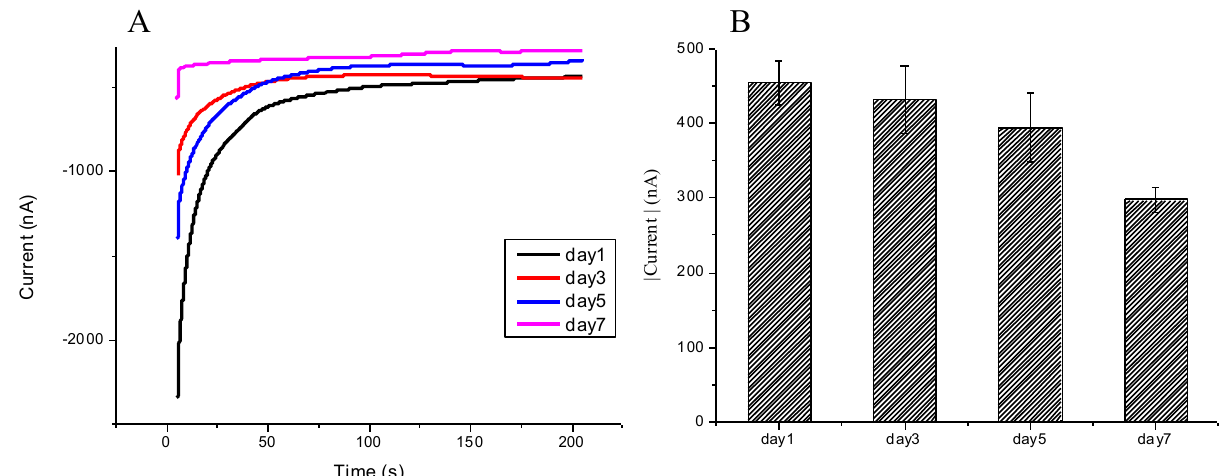
Figure 6. Demonstration of the stability of the modified SPCE after being stored in PBS solution for 1–7 days: ( A ) Chronoamperometric diagram demonstrated that the modified SPCE could be stored in PBS solution for at least 5 days and still presented reliable values of currents. ( B ) Days 1 to 5 might present reliable data; however, not day 7. The bar chart also shows the triple examinations with confidence intervals.